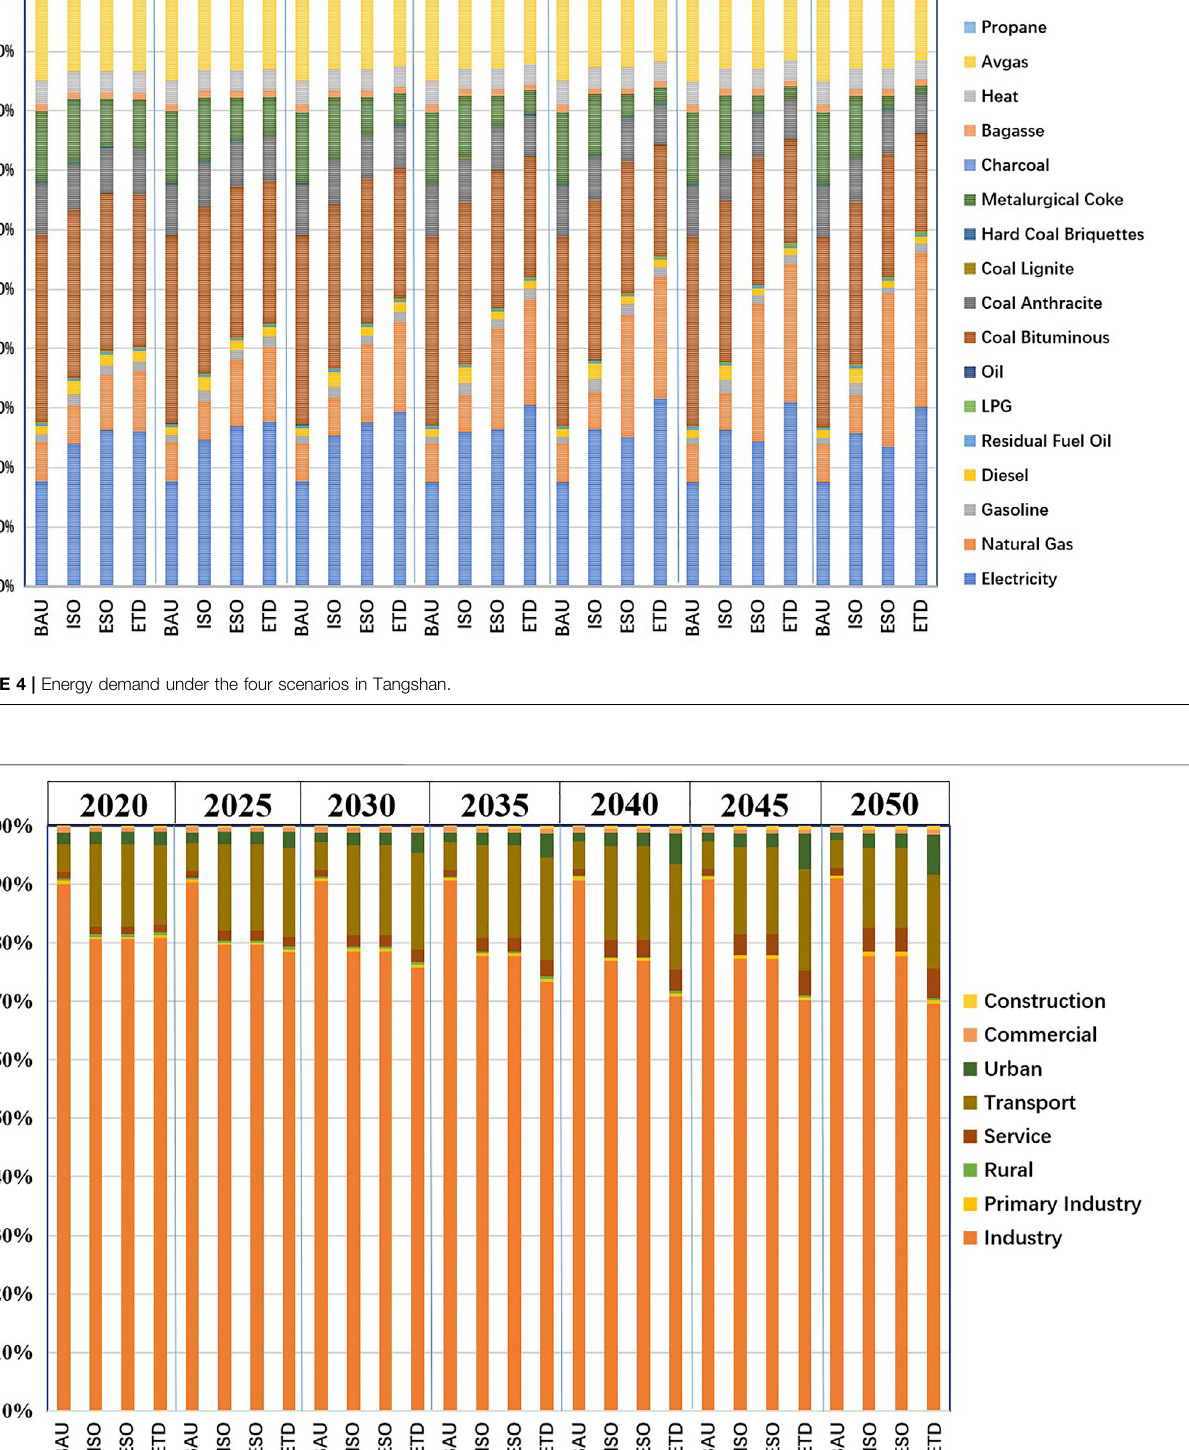
Frontiers in Environmental Science |